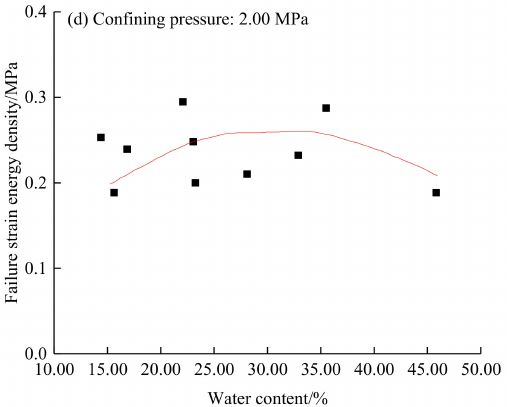
Figure 8. Comparison of the variation characteristics of the compressive strength and the failure strain energy density (( a , b ) the water content range: 26.02–28.09%, ( c , d ) the confining pressure: 2.00 MPa; the black squares represent test data points, and the red lines are the change trend lines given according to the black